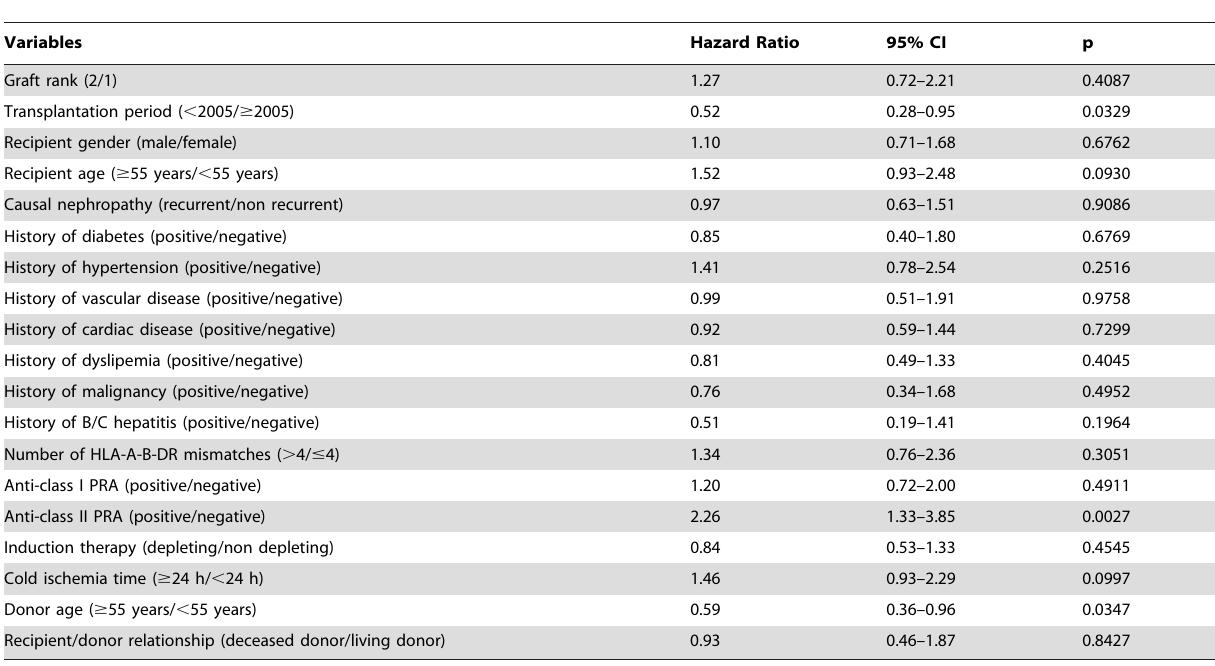
Table 4. Multivariate Cox model analysis of severe acute rejection episode (severe ARE)-free time risk factors (N